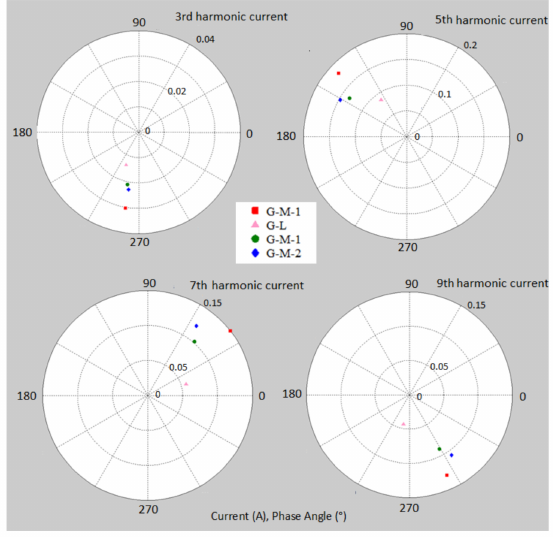
Figure 5. Phase angles of 3rd, 5th, 7th, and 9th harmonic currents of lamp